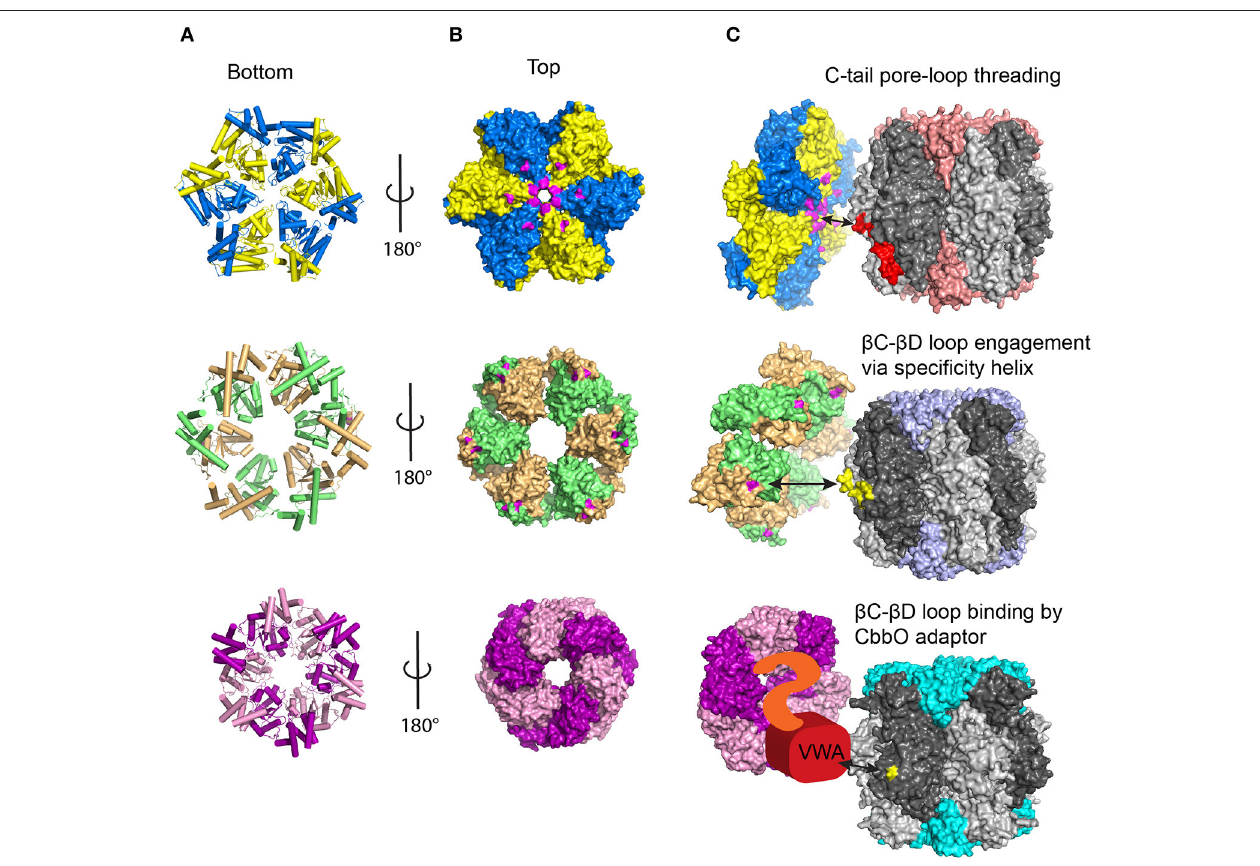
FIGURE 4 | Current models of Rubisco activase function. (A) Bottom view of the different Rca hexameric models showing helices in cylinder view. Adjacent subunits are colored differently (B) Top view of the Rca models in surface representation. Residues known to be involved in protein-protein interactions with Rubisco are colored in magenta for red and green-type Rca. (C) Current mechanistic models for the different Rca systems. See text for details. Known Rca interacting segments on Rubisco are shown in red (RbcL C-tail) and yellow (interacting β C- β D loop residues). Red-type Rca /Rubisco, PDB:3ZUH/1BXN; Green-type Rca/Rubisco PDB:3ZW6/8RUC; CbbQ/Form IA Rubisco,